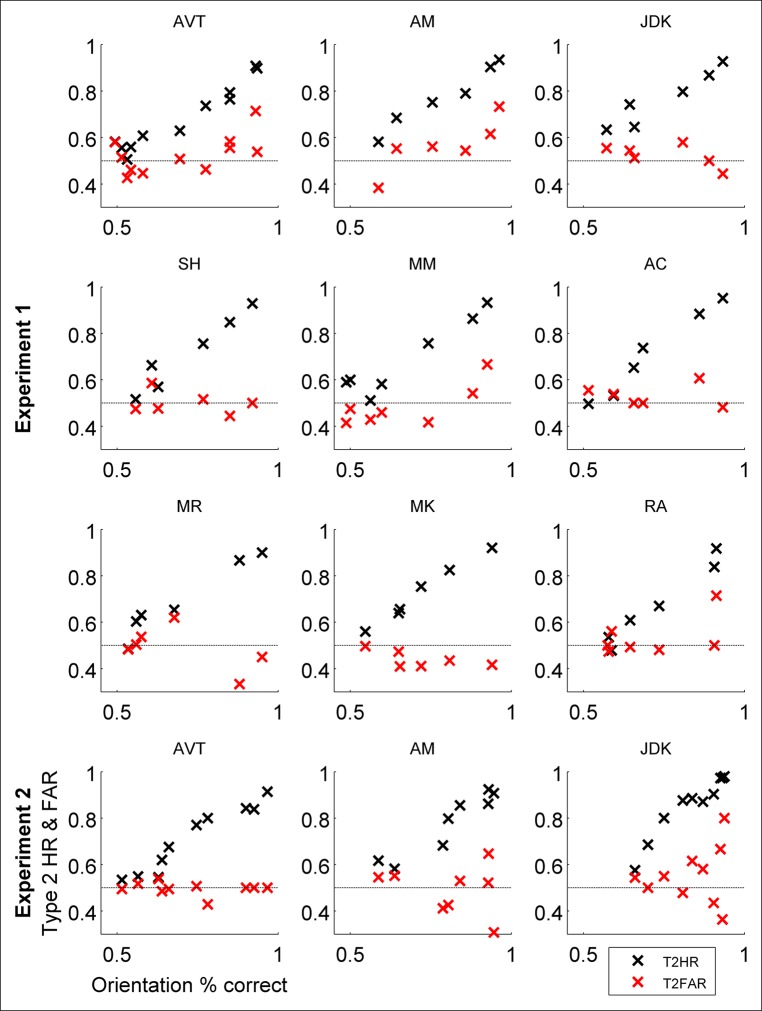
Individual subjects’ data for Type 2 hit rate (T2HR) and Type 2 false alarm rate (T2FAR).Individual subjects’ data closely resembles grouped data. The same three subjects participated in both Experiments 1 and 2.